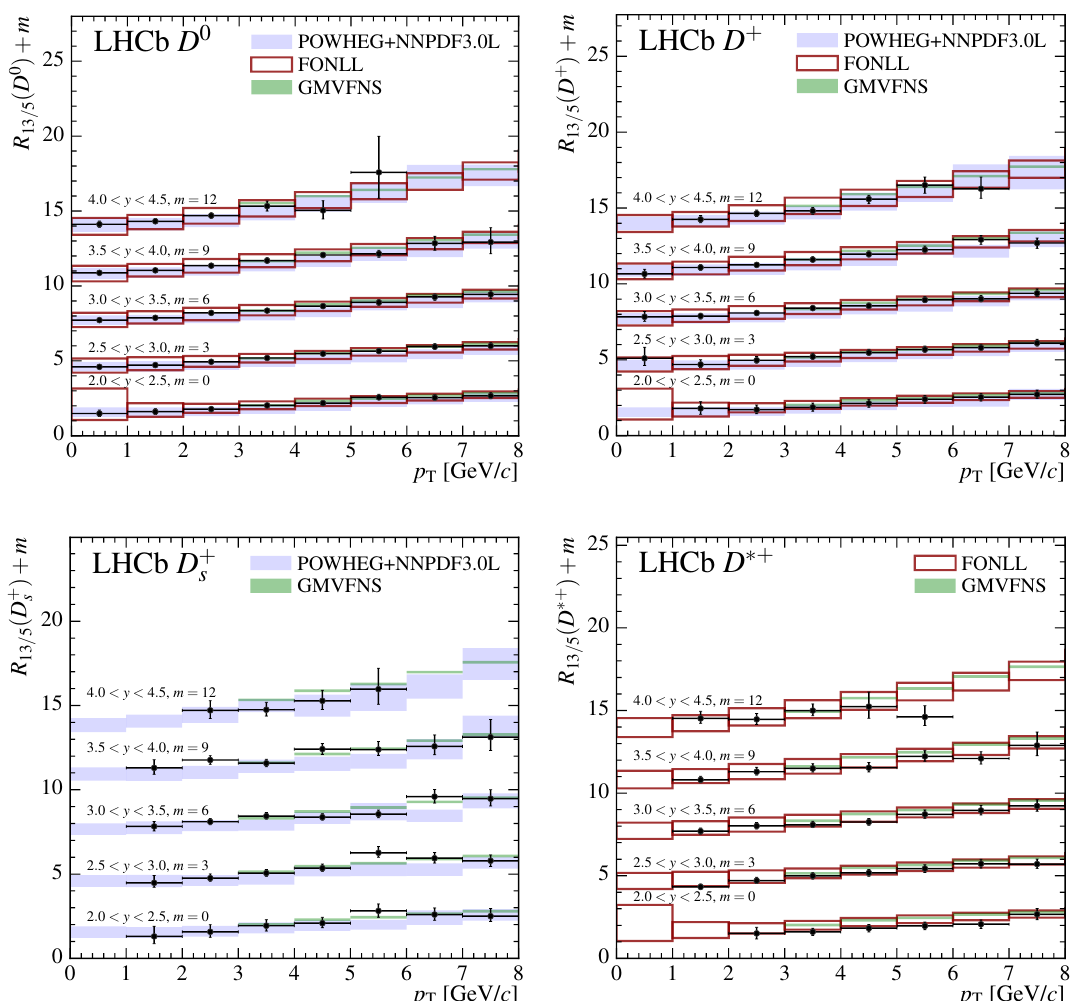
Figure 7. Measurements and predictions of the prompt D 0 , D + , D + between p s = 13 and 5 TeV. Each set of measurements and predictions in a given rapidity bin is o(cid:11)set by an additive constant m , which is shown on the plot. Only central values are provided for the GMVFNS